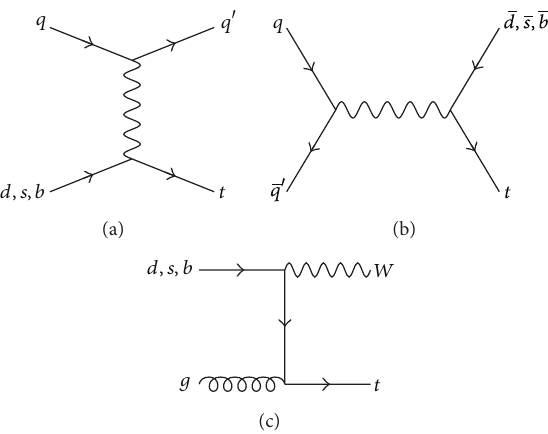
Figure 1: Representative diagrams for single top production in the Standard Model: 𝑡 -channel (a), 𝑠 -channel (b), and 𝑊 -associated production or 𝑡𝑊